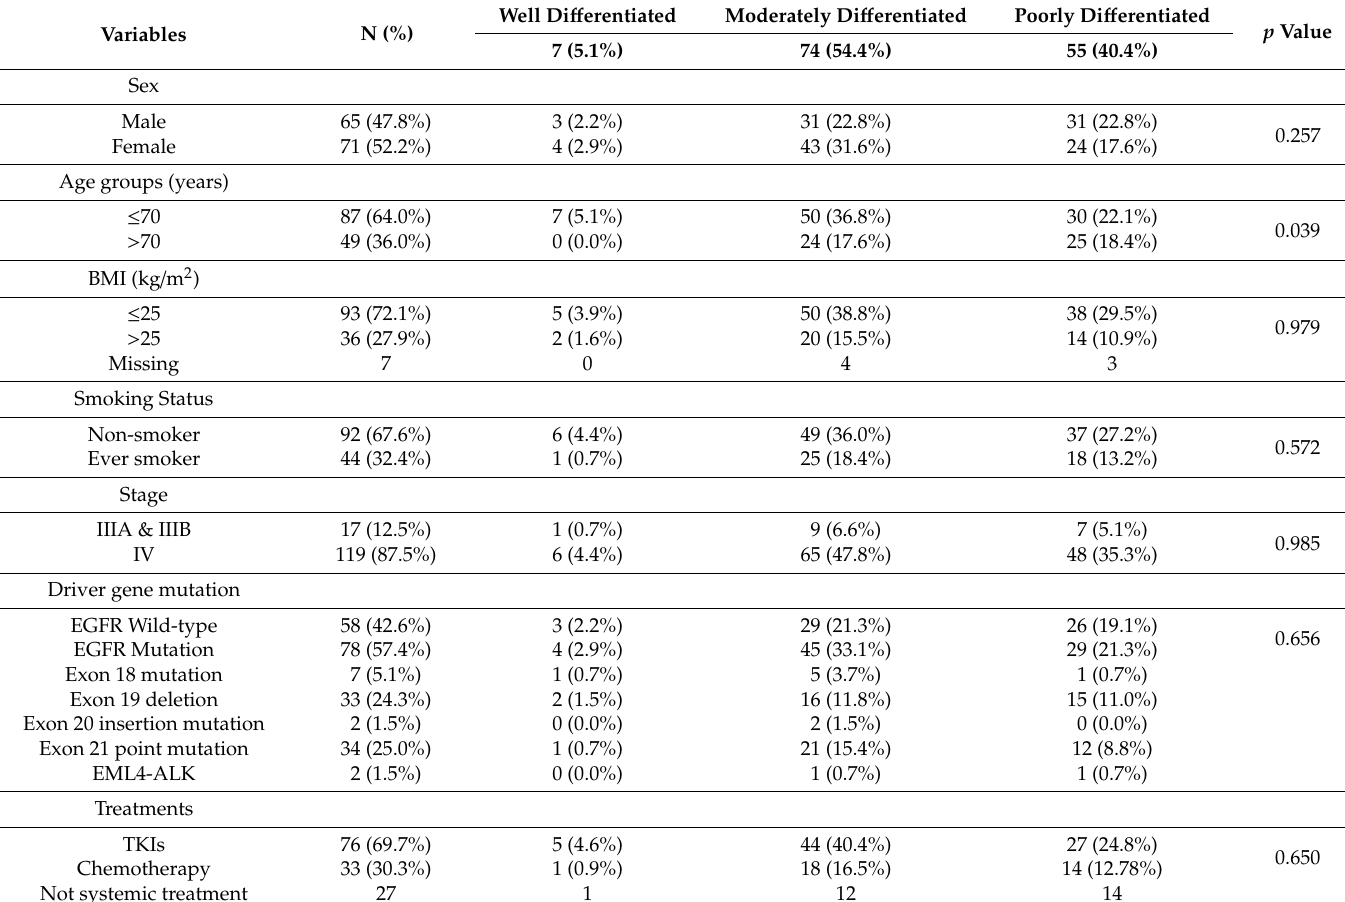
Table 2. Relationships among di ff erentiation and clinicopathological variables in advanced lung adenocarcinoma